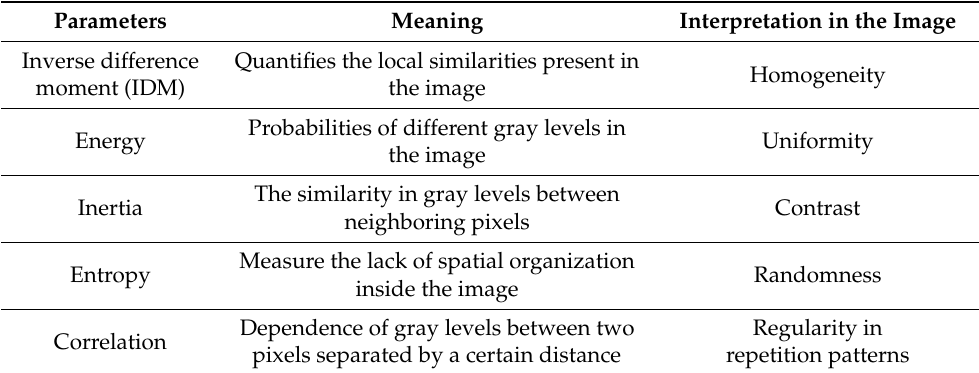
Table 4. Second-order statistics (gray level co-occurrence matrix, GLCM) parameters with the corresponding meaning and the